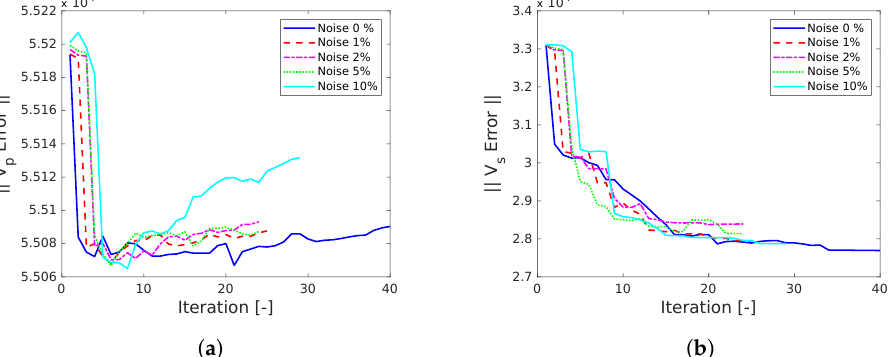
Figure 17. Reconstruction error for a cyclic multi-frequency stage inversion considering different noise levels in the data. ( a ) V p reconstruction error ( b ) V s reconstruction